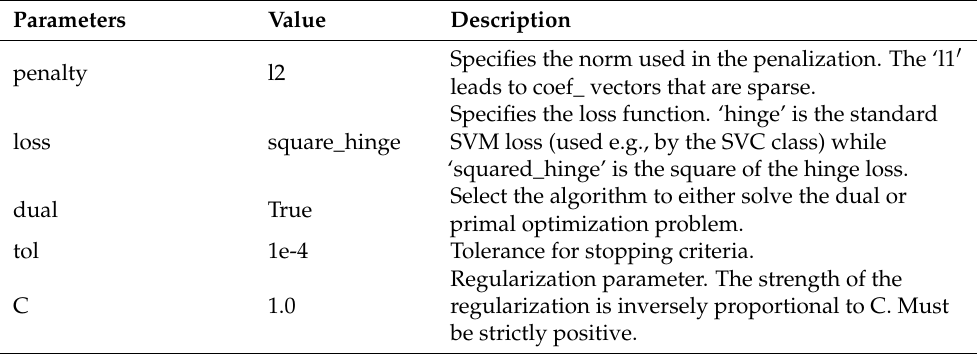
Table 9. LSVM (OVA) parameters from scikit-learn